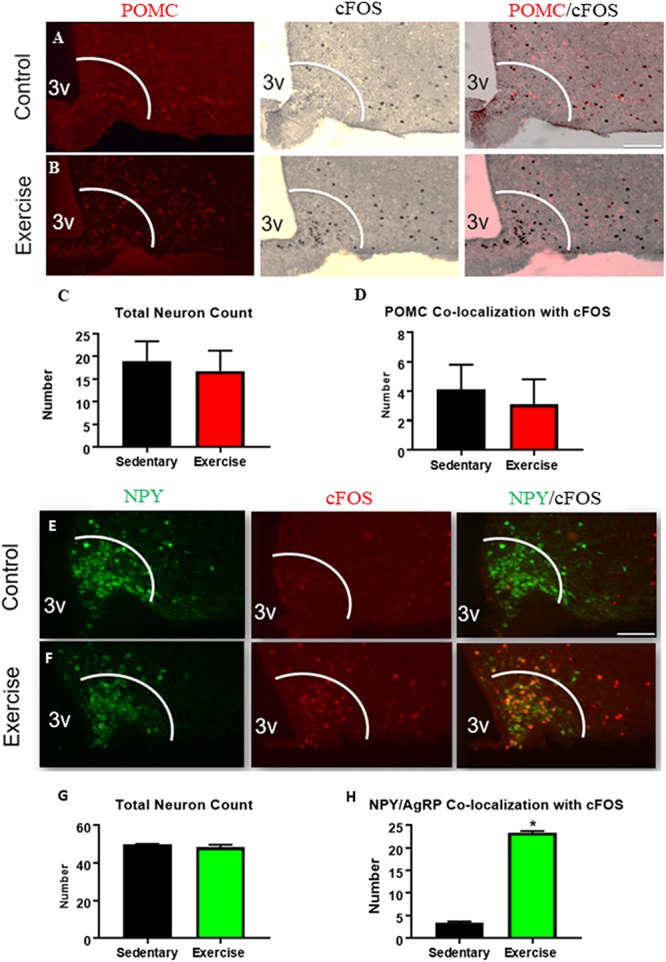
An acute bout of exercise increases ARCAgRP/NPY neuron activation while ARCPOMC neuron activation remains unchanged. Expression of cfos in POMC-expressing neurons in ARC sections from (A) sedentary control and (B) exercise groups immediately after an acute bout of exercise. (C) Average POMC neuron count per slice. (D) Average number of neurons that are co-localized with cfos. Expression of cfos in ARCAgRP/NPY neurons in (E) sedentary control and (F) exercise groups immediately after an acute bout of exercise. (G) Average ARCAgRP/NPY neuron count per slice (H) ARCAgRP/NPY neuron’s that are co-localized with cfos. 3V: third ventricle; scale bars represent 50 μm. Bar graphs show Mean + SEM. (N = 6 male mice per group), * indicates p < 0.05 vs. sedentary group.